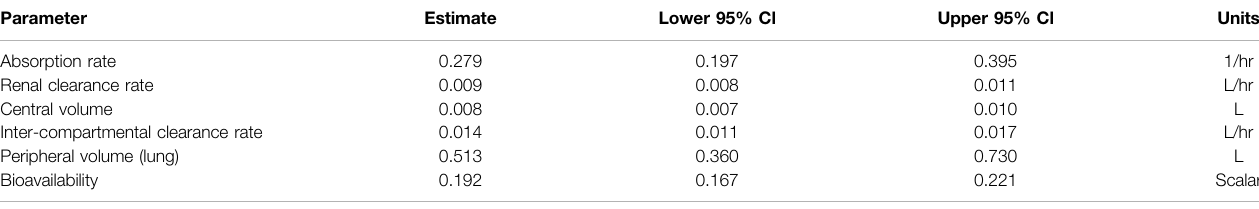
TABLE2| Two-compartmentmodelbaseparameterestimatesforcontrolgroup,including95%con fi denceintervalbounds; fi ttedtoplasma+urinedata.Lrepresentsliters in the units column. Parameter